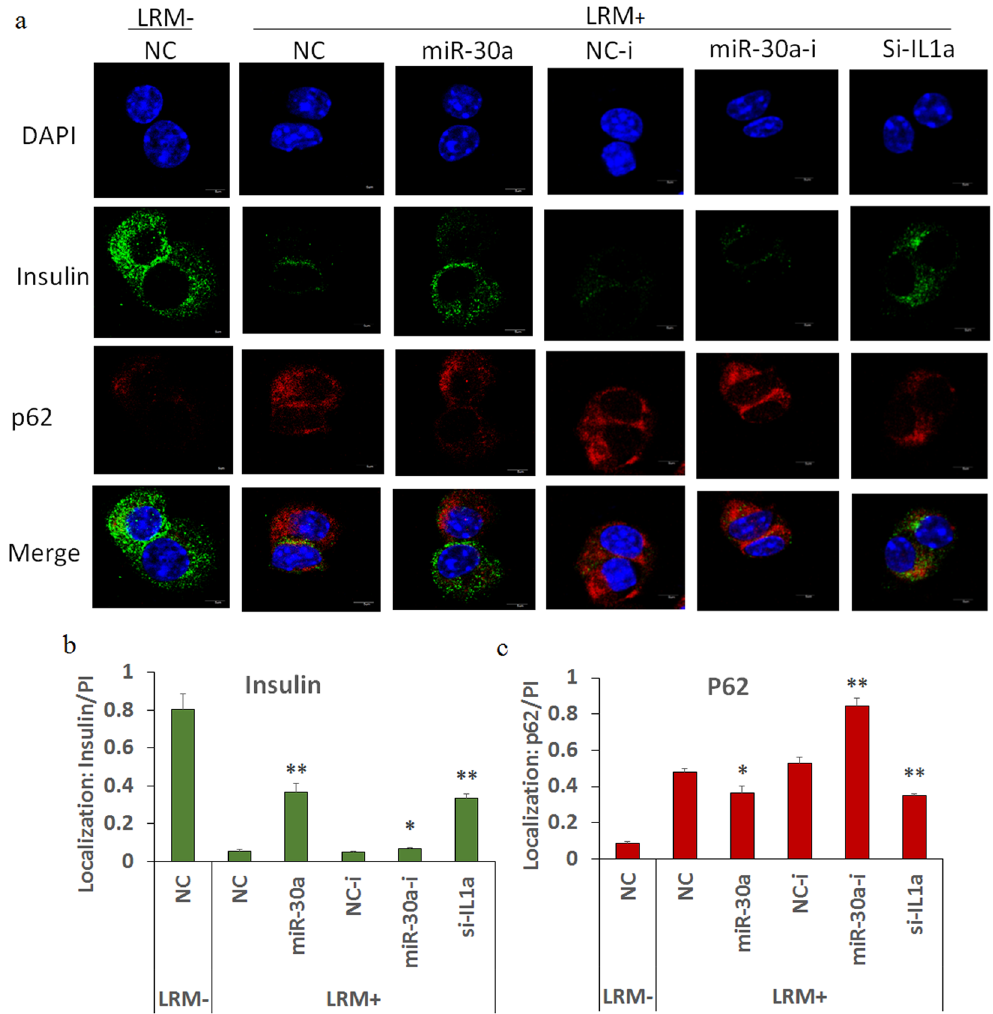
Figure 6. Effects of miR-30a on p62 and insulin localization in Beta-TC-6 cells. ( a – c ) IF and confocal assay showing that miR-30a significantly regulates p62 and insulin localization in Beta-TC-6 cells after 24 h of LRM induction; the increased intracellular insulin level with miR-30a might be associated with decreased intracellular p62. The gray density values of proteins and DAPI were calculated by ImageJ software, and these protein levels in cells were normalized with DAPI (PI); approximately 100 cells in each slide (3 slides per group) were randomly selected and the average value in each slide was obtained for further statistical analysis. LRM + / − , incubation with or without LRM; NC, negative controls of miRNA mimics; NC-i, negative controls of miRNA inhibitors or siRNA; miR-30a-i, miRNA-30a inhibitor; and si-IL1a, silencing mRNA fragment of Il-1a. Data are expressed as the Mean ± SD (n = 3); * P < 0.05 and ** P < 0.01 vs. NC or NC-i (LPS/LRM + ),